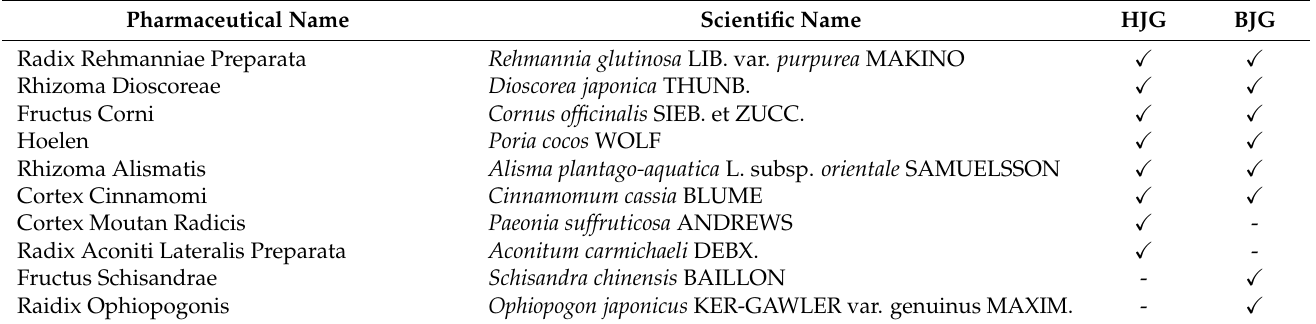
Table 1. Compositions of HJG and